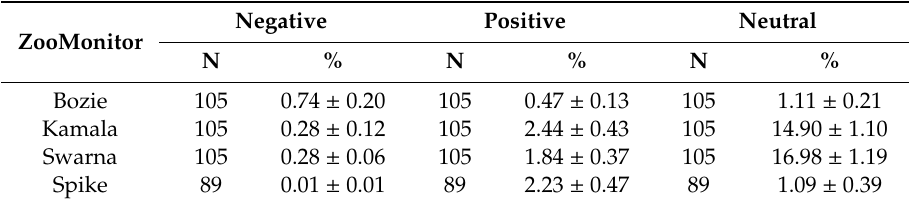
Table 5. Mean (% ± standard error) proportion of time that Maharani was involved in social interactions with other elephants during ZooMonitor 30 min focal observations. Mean weekly proportion of time for each type of social interaction during N number of